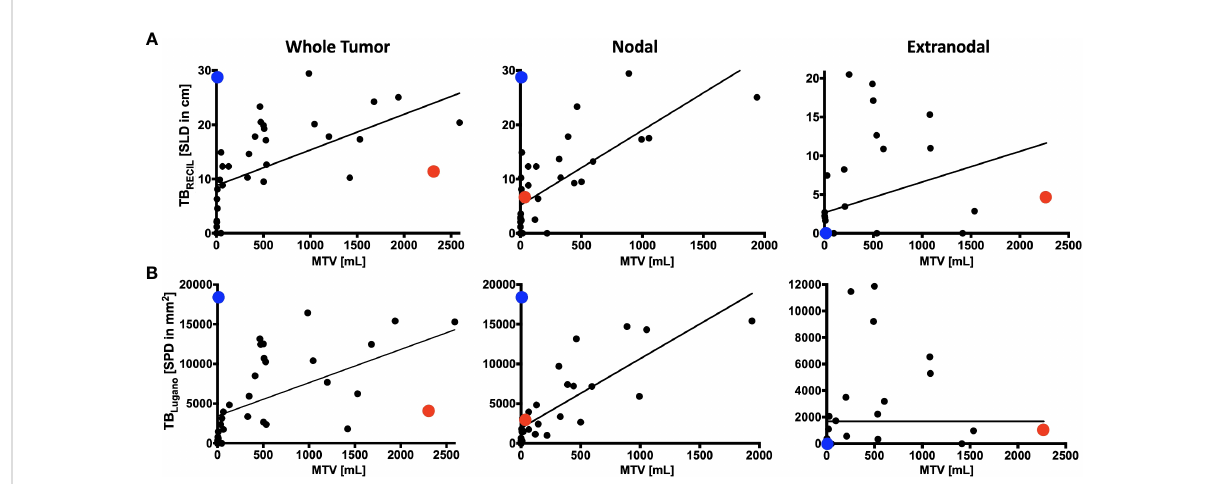
FIGURE 2 Comparison of RECIL, Lugano and Metabolic Tumor Burden Quanti fi cation. Depicted is the correlation of tumor burden at baseline PET/CT prior to CAR T-cell therapy according to RECIL (TB RECIL ; A ) and Lugano criteria (TB Lugano ; B ) on the y-axis to metabolic tumor volume (MTV) on the x-axis. Tumor burden is shown as whole tumor burden on the left, nodal tumor burden in the middle and extranodal tumor proportion on the right. An extreme outlier with high MTV to TB RECIL /TB Lugano ratio was marked with red. Another outlier with high TB RECIL /TB Lugano compared to MTV was marked with blue. The disease phenotypes of these two cases will be illustrated in Figure 3.